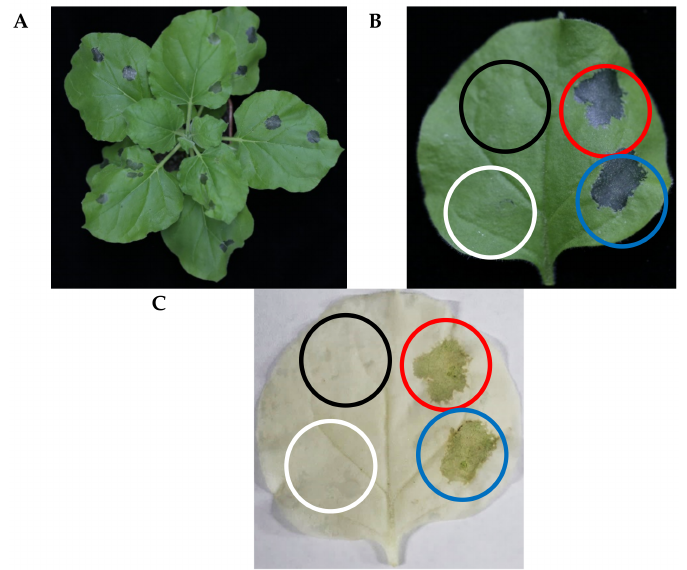
Figure 5. Hypersensitive response (HR) reaction induced by EPS isolated from Clavibacter michiganen- sis on leaves of N. benthamiana. Black, white, red, and blue circles indicate water treatment (mock control), 5 mg/mL sucrose treatment (negative control), 2 mg/mL EPS treatments, and 5 mg/mL EPS treatments, respectively. ( A ) Results were photographed 3 days after infiltration treatment for whole plants. ( B ) Single leaf of N. benthamiana (n = 6). (C) Decolorized leaf of N. benthamiana (n =